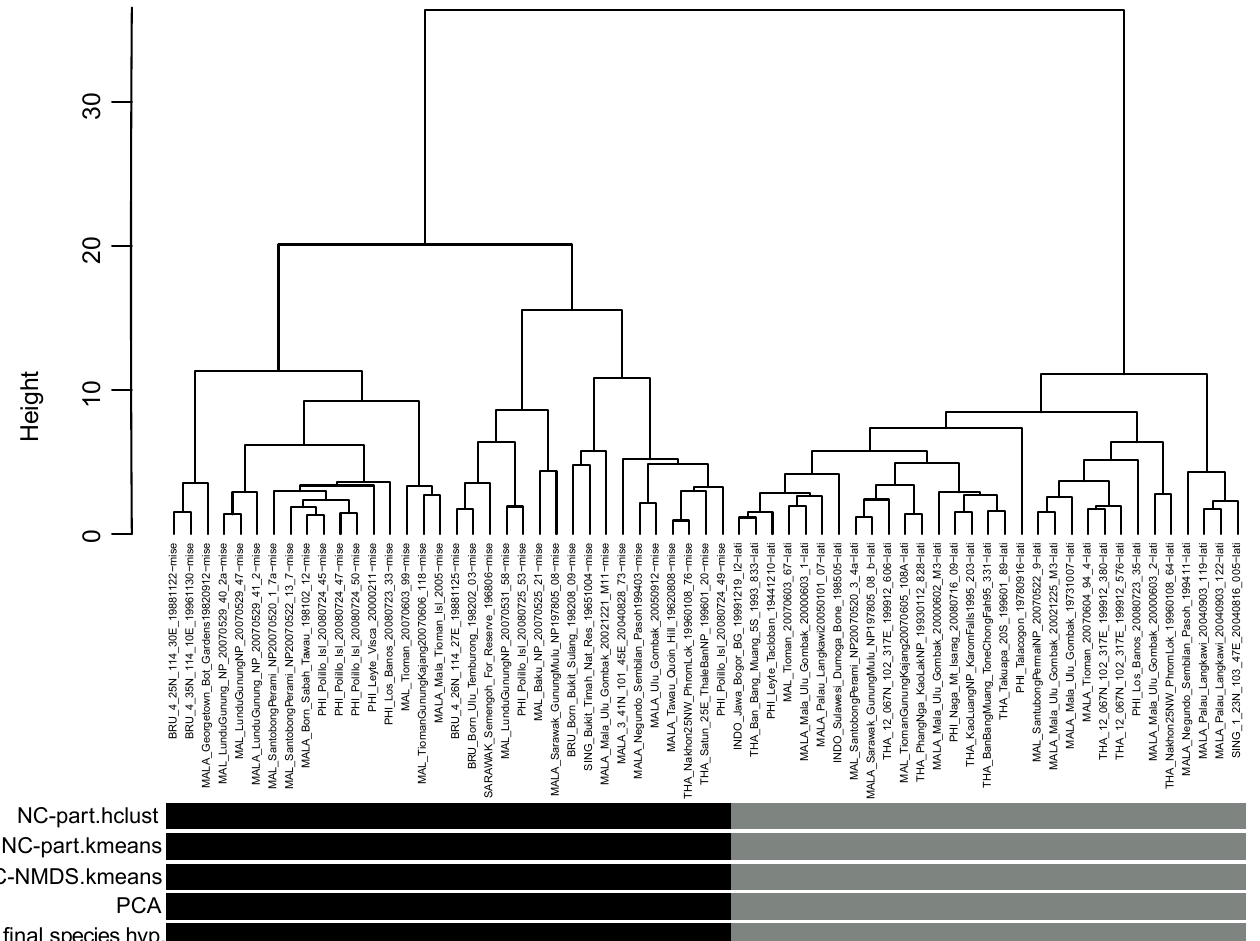
Figure 30. Separation of 65 nest samples of Cardiocondyla micropila n.sp. (black bars) and C. latifrons n.sp. (grey bars) by NC-Ward, NC-part.hclust, NC-part.kmeans, NC-NMDS.kmeans clus- tering and by a principal component analysis considering the morphometric characters CS, sqPDG, PLG/CS, EYE/CS and